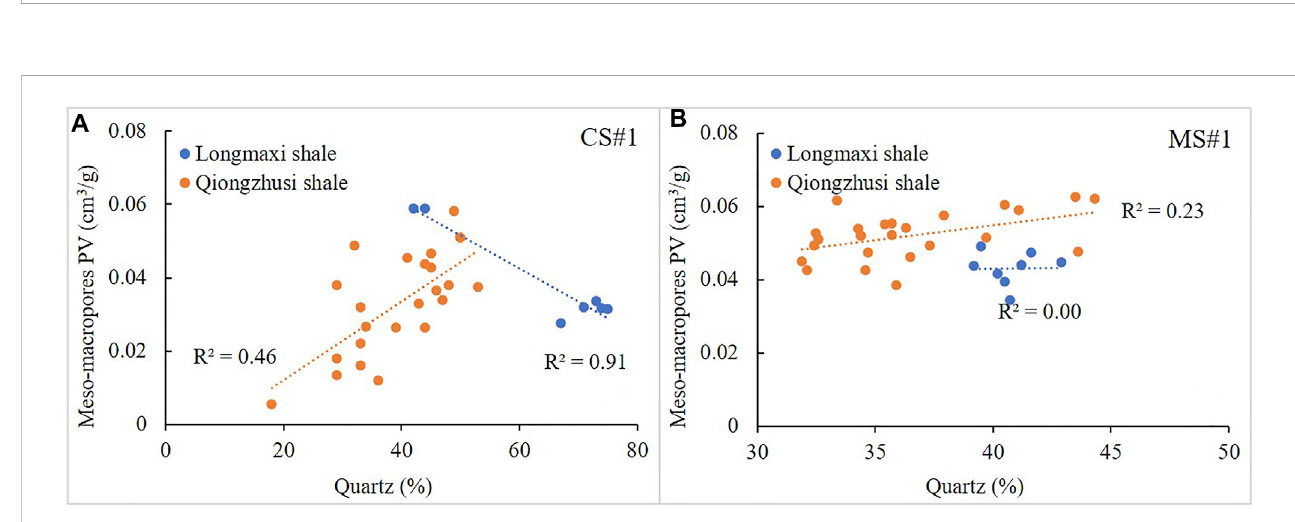
FIGURE 6 Correlation between quartz content and PV of meso-macropores. (A) CS#1 well; (B) MS#1